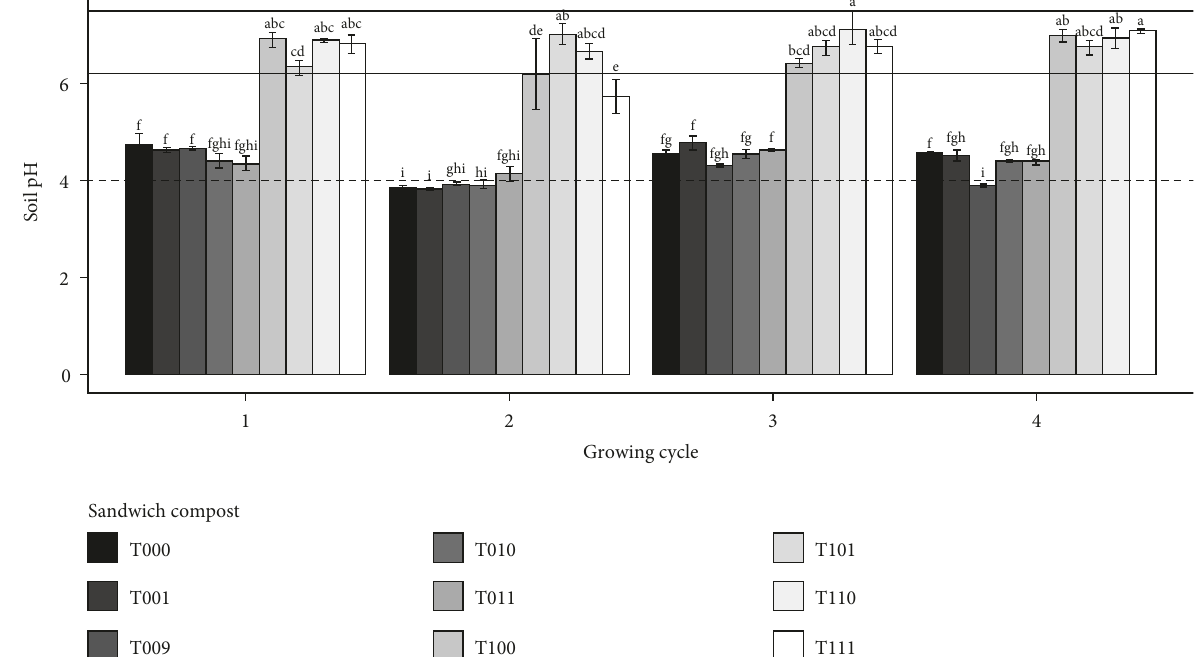
Figure 1: Effect of the growing cycle and Sandwich compost amendments on soil pH. Mean ± standard error with different letters is significantly different at P < 0 . 05 when using DMRT. The dotted line is referred to as the original soil pH 4. The solid line is referred to as the optimum soil pH of